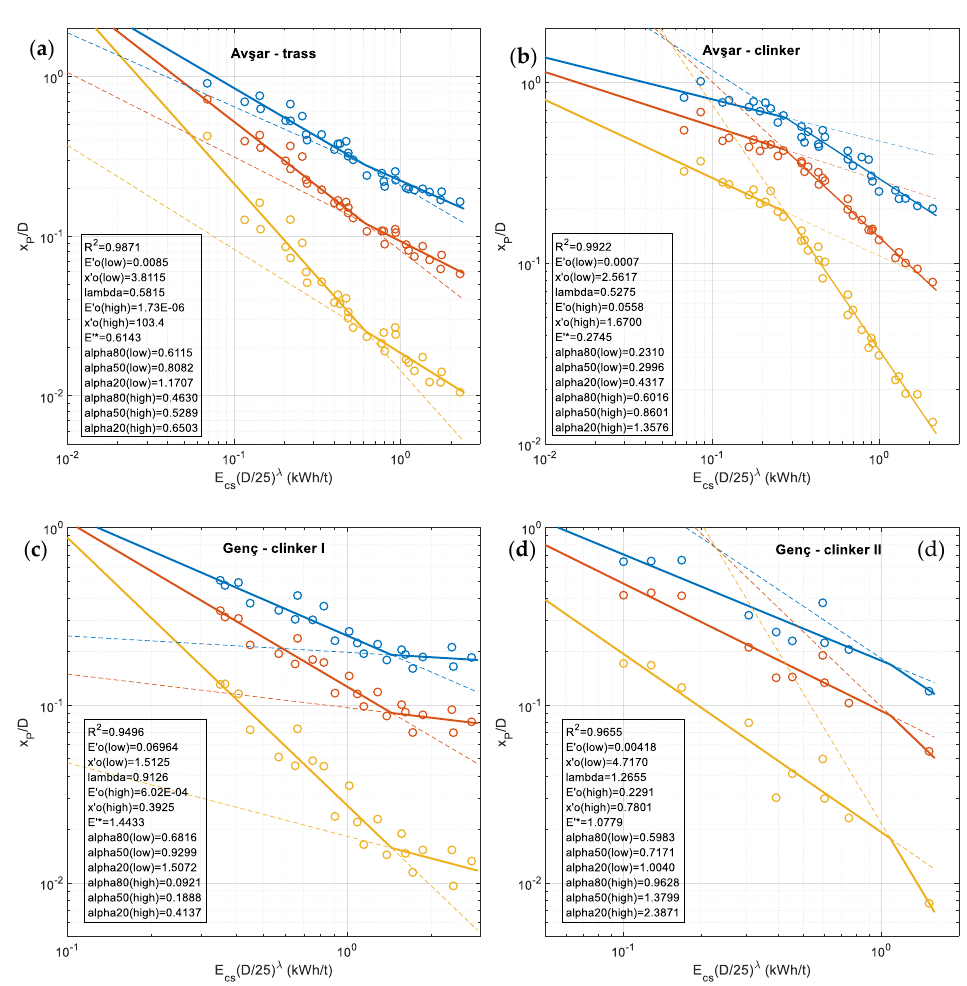
Figure 8. Double fragmentation energy fans for Avsar’s [23] trass ( a ) and clinker ( b ), and Genç’s et al. [24] clinker I ( c ) and clinker II ( d ). Circles are data points. Colors correspond to percentage passing: blue 80 %, red 50 %, yellow 20 %. Table 4. Comparison of 𝑏 -values from CDF fitting with Swebrec function and fan fitting.